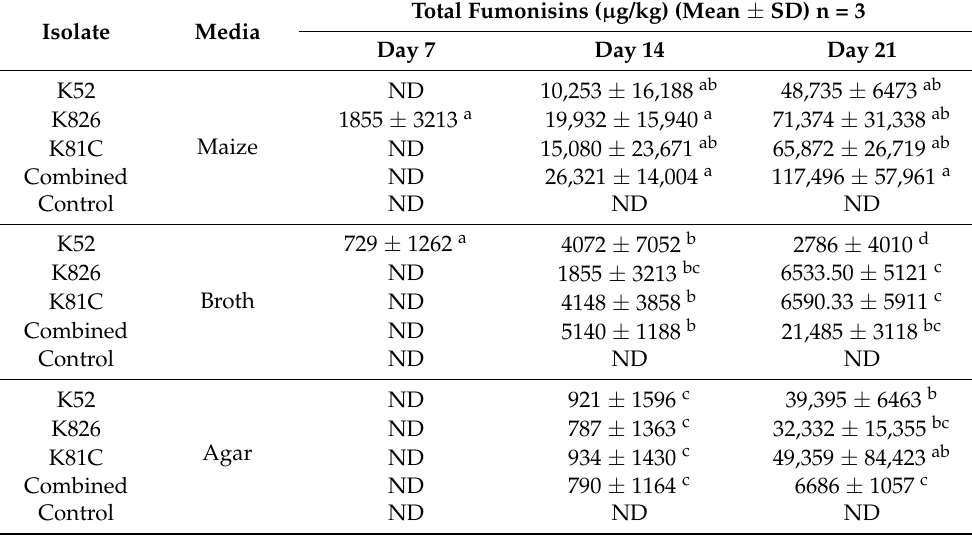
Table 2. The total fumonisin levels in three media inoculated with various F. verticillioides strains and incubated in chambers fitted with white light or on a rotary